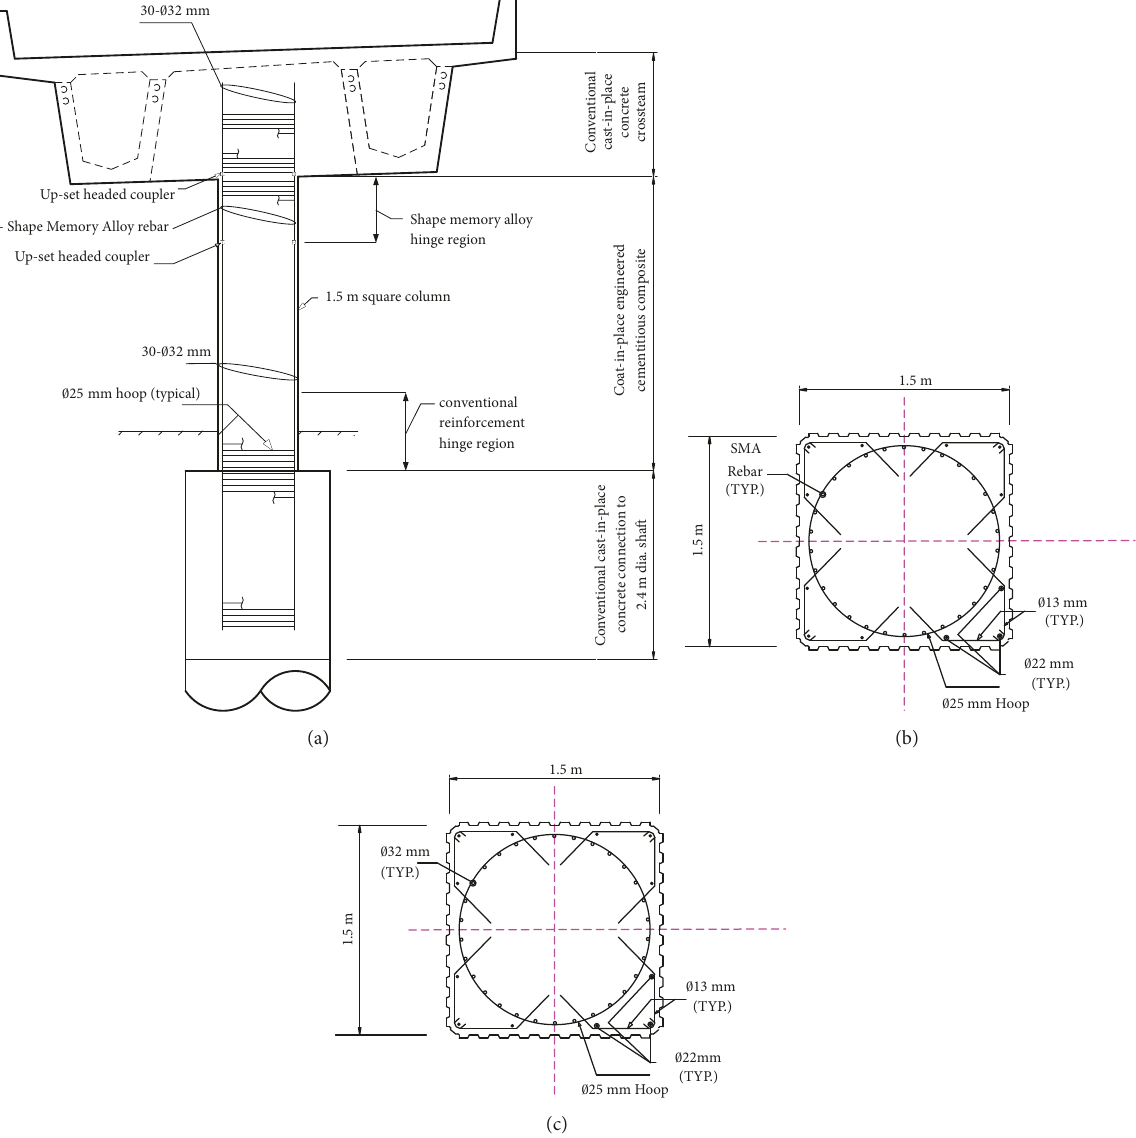
Figure 2: SR99 pier elevation column cross section details: (a) pier elevation, (b) SMA section, and (c) mild steel section.